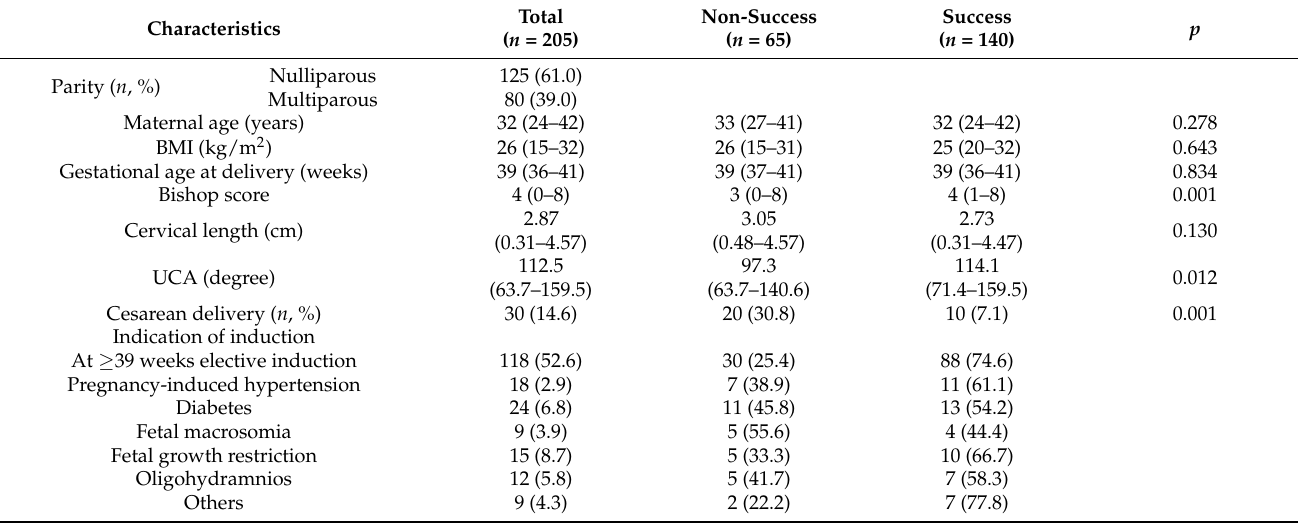
Figure 2. Flowchart of participants inclusion; TVS, transvaginal sonographic. Table 1. Clinical characteristics of the study population.